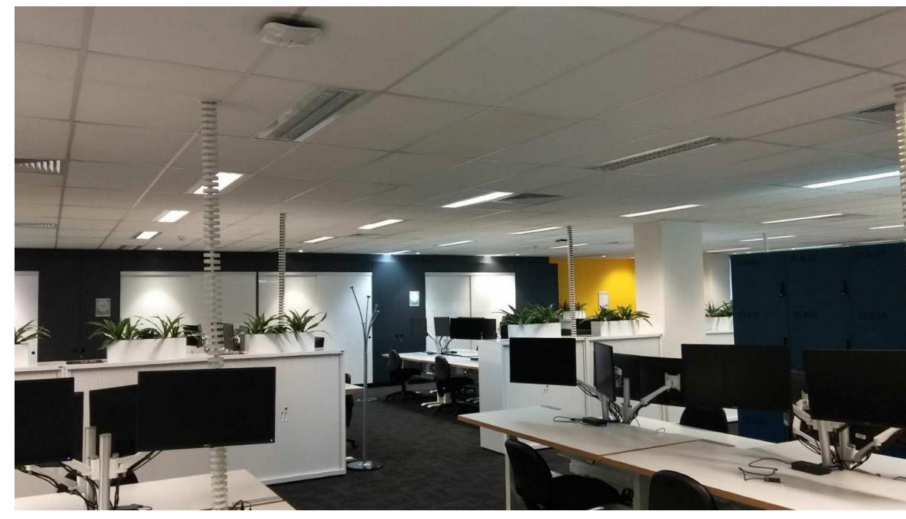
Figure 5. The indoor test environment.